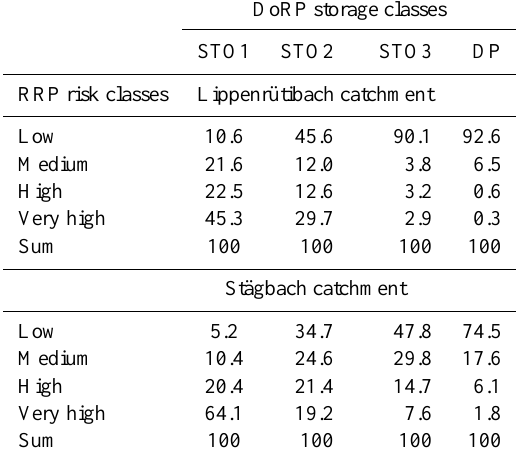
Table 4. Amount of RRP risk class pixel within the DoRP stor- age classes in percent of the total area of the storage classes [%]. The areal extent of the RRP risk classes during the large runoff events (Lippenrütibach: May 1999, Stägbach: June 2010) was taken for comparison. STO1 – low storage capacity, STO2 – intermediate storage capacity, STO3 – high storage capacity, DP – deep